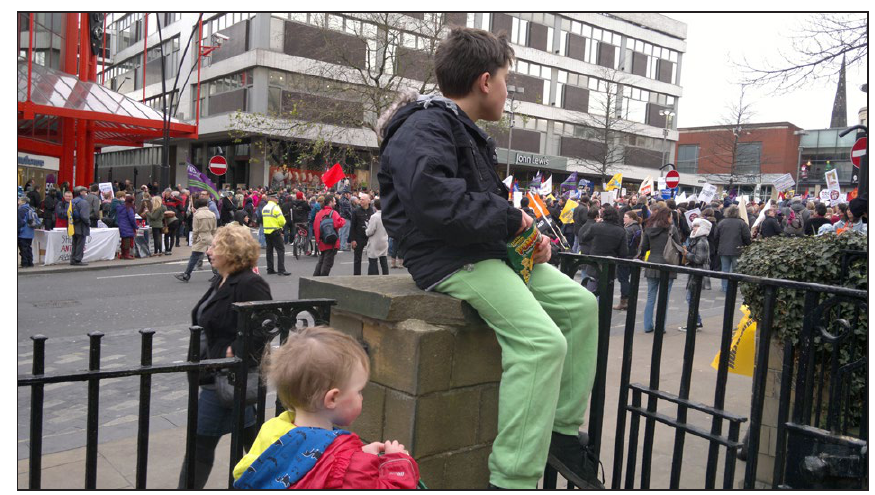
Figure 28: Paula McCloskey Boys on the fence, digital photograph, 2011.